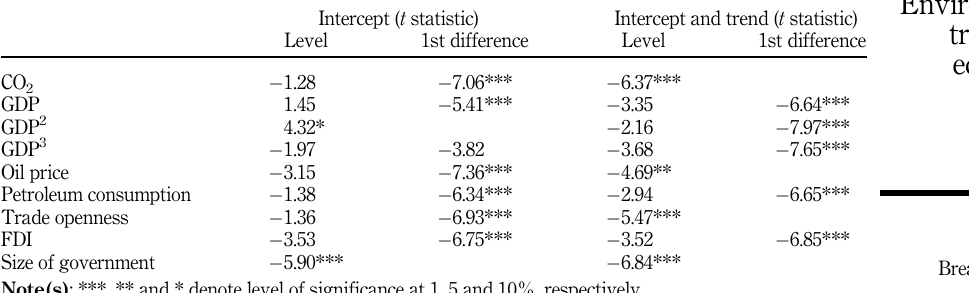
Table 1. Breakpoint